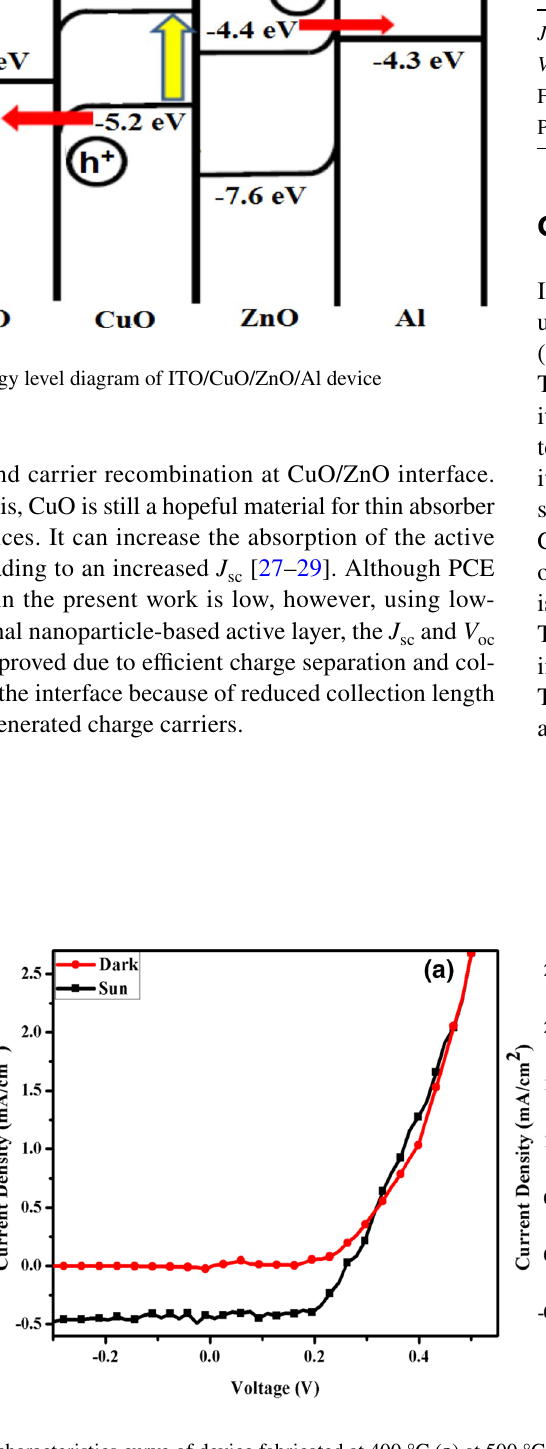
Fig. 8 J – V characteristics curve of device fabricated at 400 °C ( a ) at 500 °C ( b )